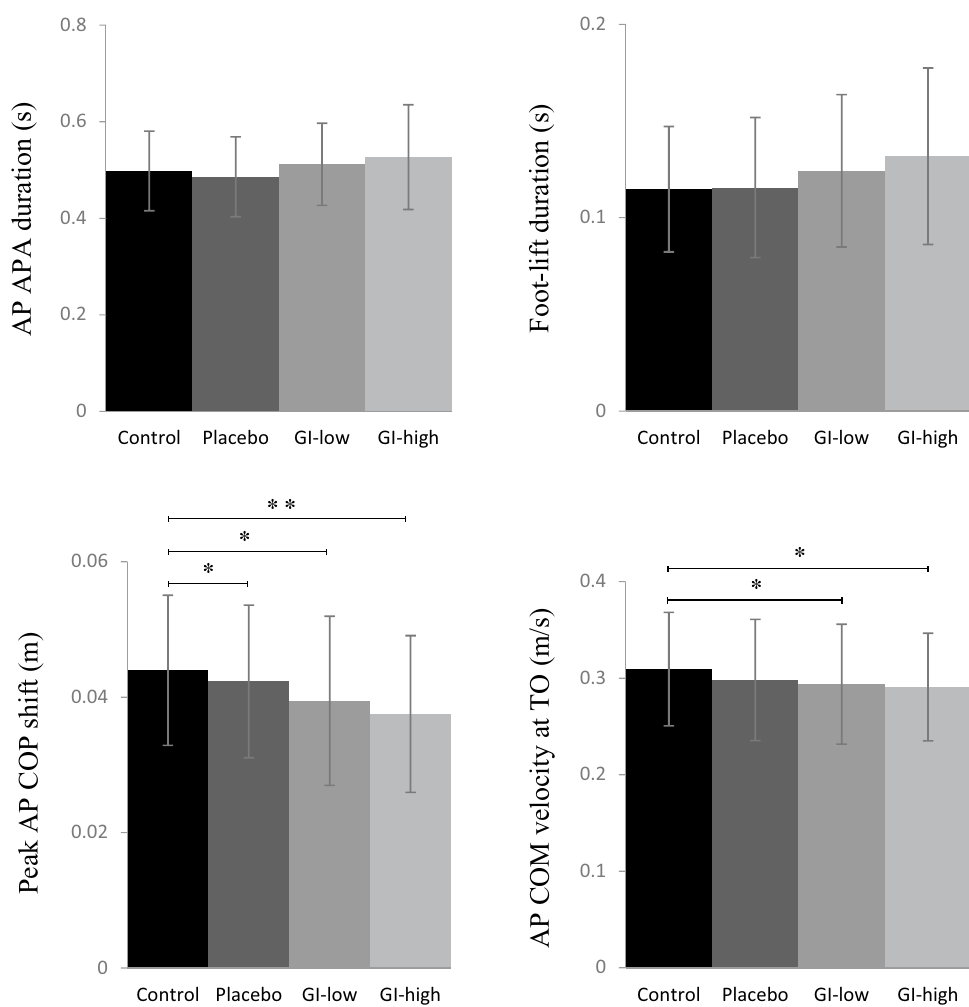
Figure 2. Effects of the condition on selected APA and foot-lift parameters. Reported are mean values (all participants together) + 1 SD. APA anticipatory postural adjustments, AP anteroposterior, COP centre-of- pressure, COM centre-of-mass, TO swing toe-off; *, **: significant difference between bars with p < 0.05 and p < 0.01,